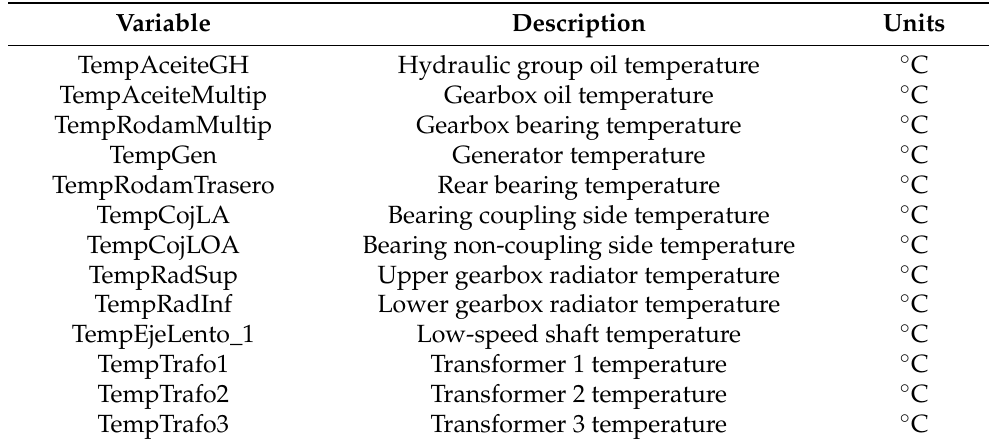
Table 4. Component temperature variables.